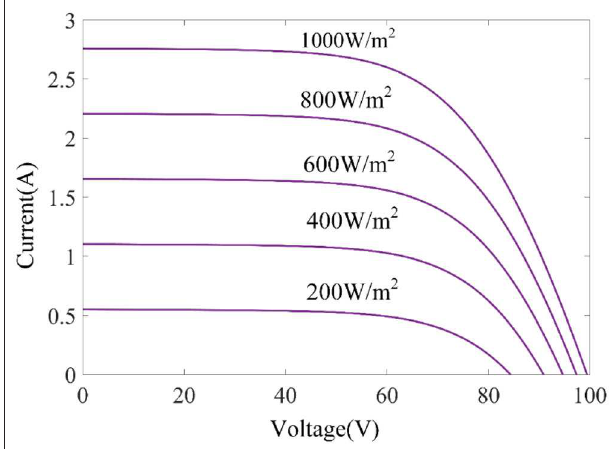
FIGURE 4 | IV characteristics of Solyndra SL-001-200 photovoltaic (PV) panel.